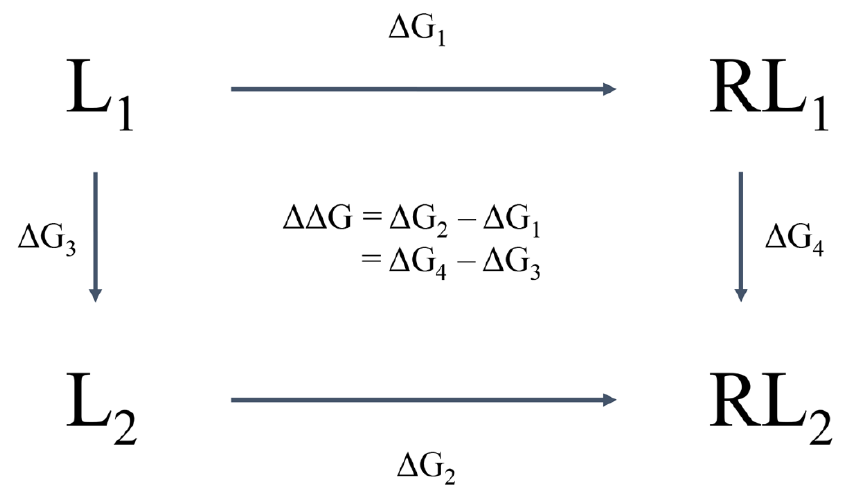
Figure 15. Thermodynamic cycle for relative binding free energy calculation. ∆ G 1 and ∆ G 2 are the binding energy of reference ligand L 1 and modified ligand L 2 , respectively, ∆ G 3 is the free energy difference of two ligands in solution, ∆ G 4 is the free energy difference of two ligand–receptor complex in solution.